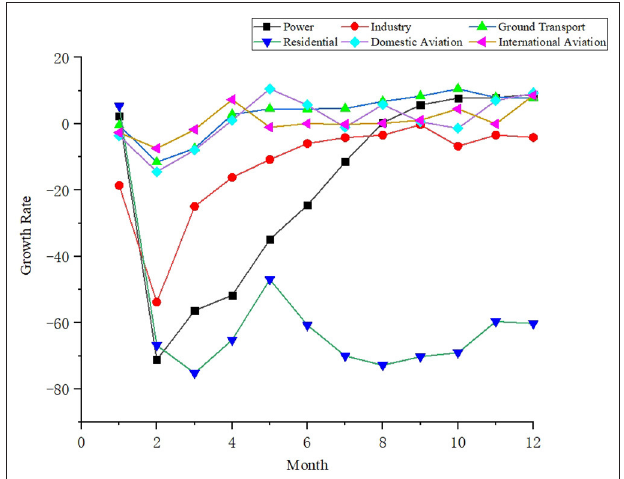
FIGURE 3 | Trend line for the growth rate of carbon emissions of 30 provinces in 2020.